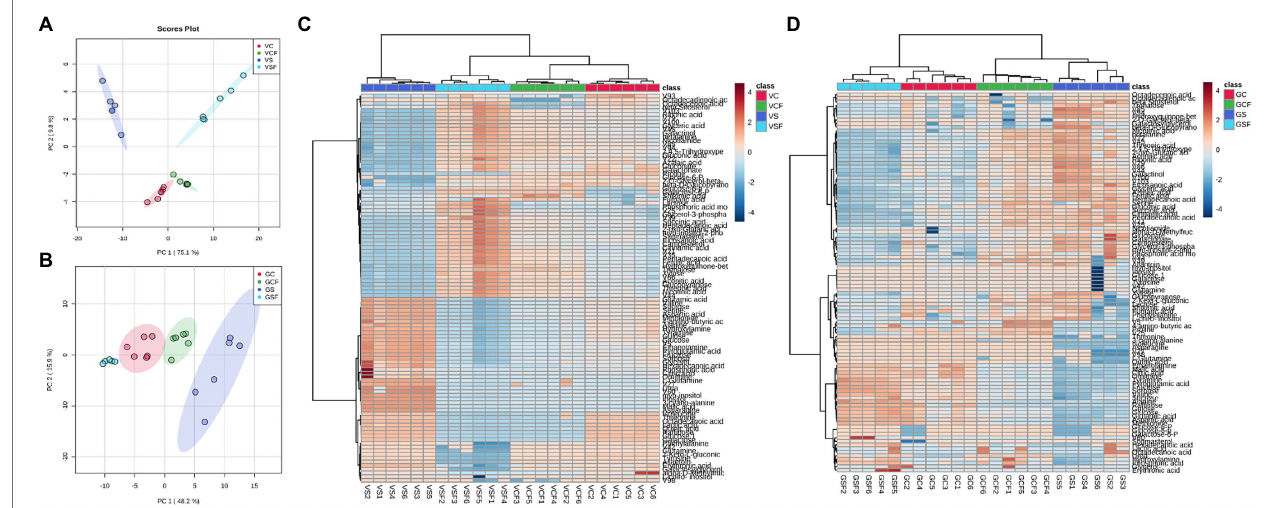
FIGURE 4 | Principal Component Analysis (PCA) score plot and Heatmaps for cv. Vlamingh (A,C) and cv. Gairdner (B,D) under four treatments—C, control treated roots, S, Salt treated roots (200 mM NaCl), CF , control + fungus, SF, salt + fungus. The fungal inoculated samples (VCF and VSF) separate from the uninoculated samples (VC and VS ) in cv. Vlamingh on component 1 (PC1). The salt treatment contributed to distinct separation on PC2 in cv. Vlamingh. In cv. Gairdner, PC1 clearly separates treatment GS from the other three treatments (GCF, GSF and GC). Unsupervised hierarchical clustering of lipid species is represented by the heatmaps (rows). The samples are represented in the column, while the detected lipid species are displayed in the row. Metabolites with a lower relative abundance are shown in blue, whereas those with a higher relative abundance are shown in red. The R package heatmap was used to cluster the data using Euclidean distance